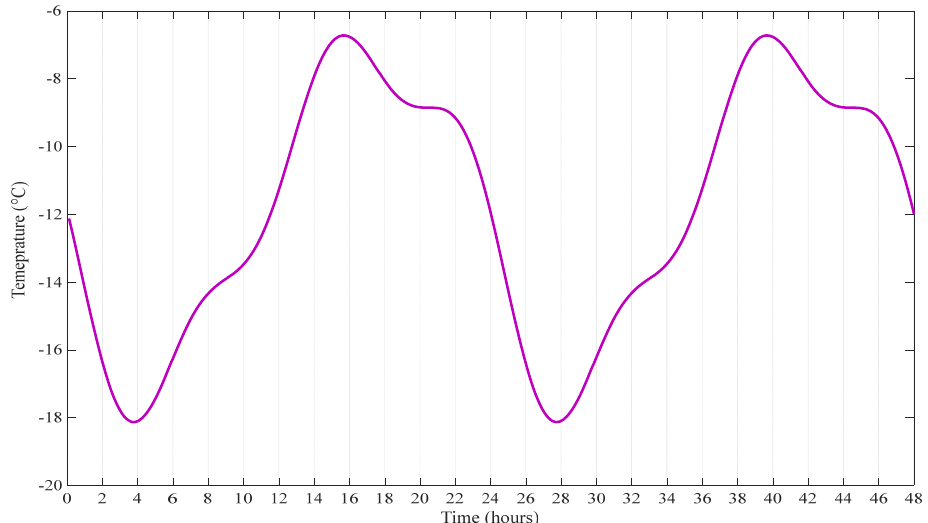
Figure 6. Outdoor temperature profile.